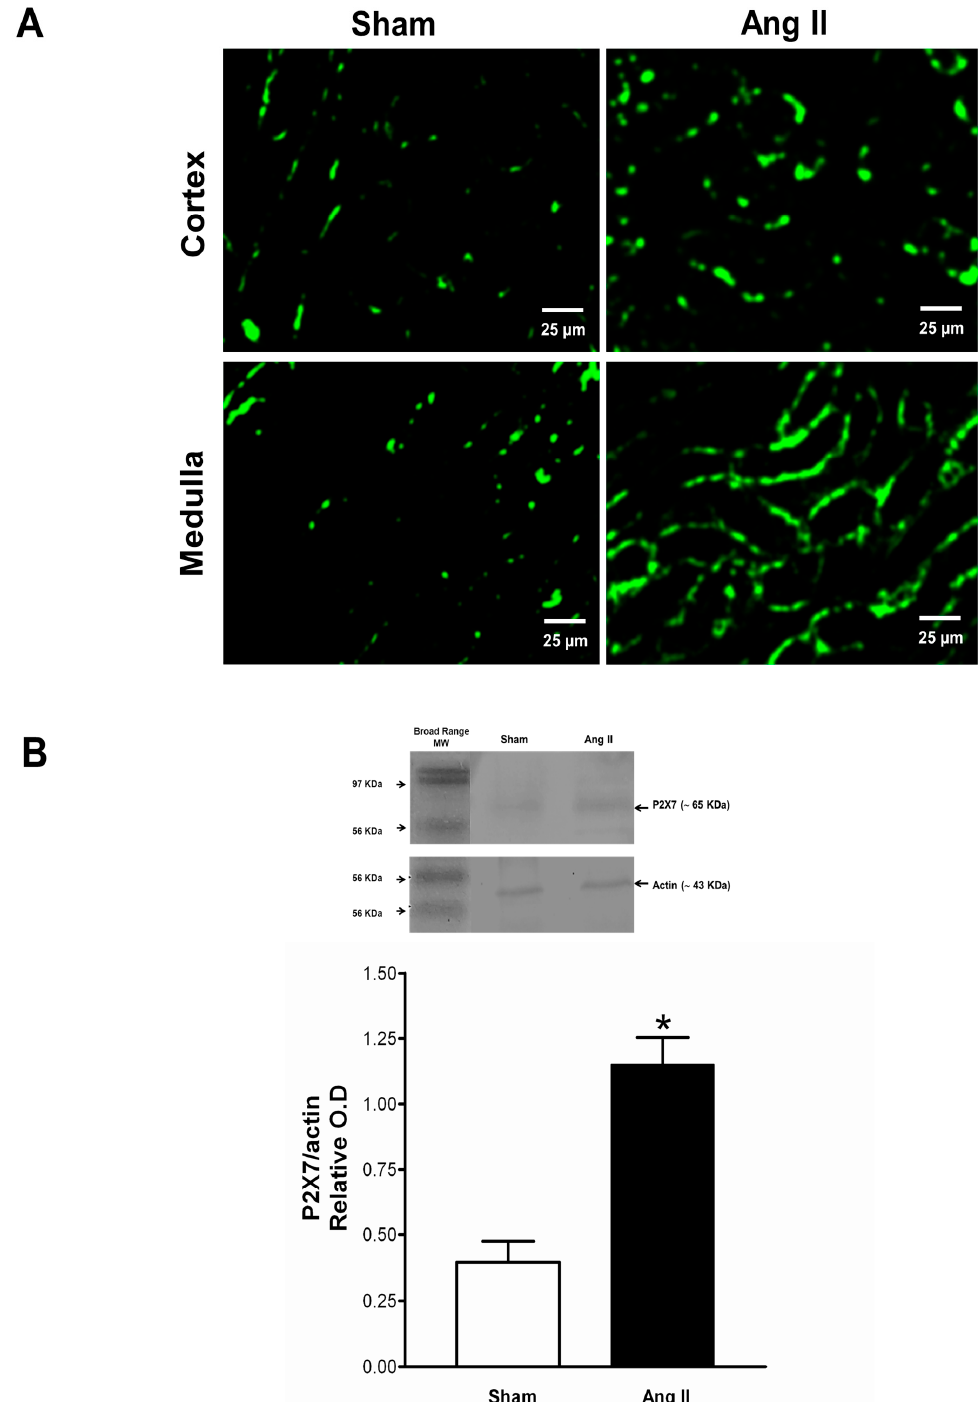
Figure 4. P2X7 receptors identified by immunofluorescence, in renal cortex and medulla in Sham and Ang II-infused rats. The expression of P2X7 receptors in the Ang II group is localized in tubular membranes ( A ). Western blot ( B ) showed abundance of the P2X7 receptor protein in the Ang II group ( n = 7 per group). * p < 0.01 vs. Sham. Ang II = angiotensin II, BBG = Brilliant blue G